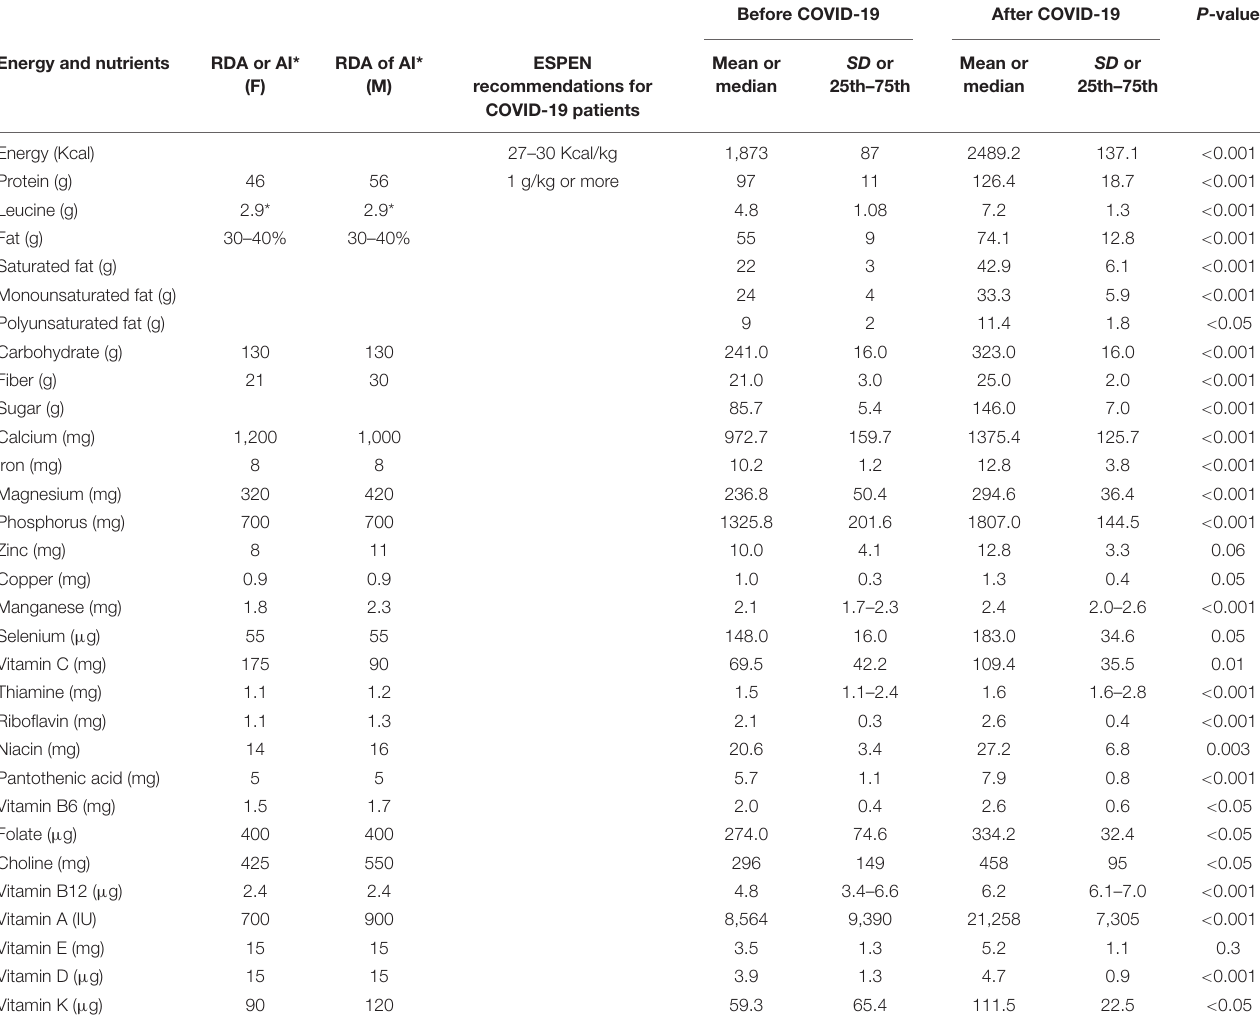
TABLE 3 | Energy, macro, and micro-nutrient content of the menu provided before and after the conversion of our hospital to a COVID hospital.